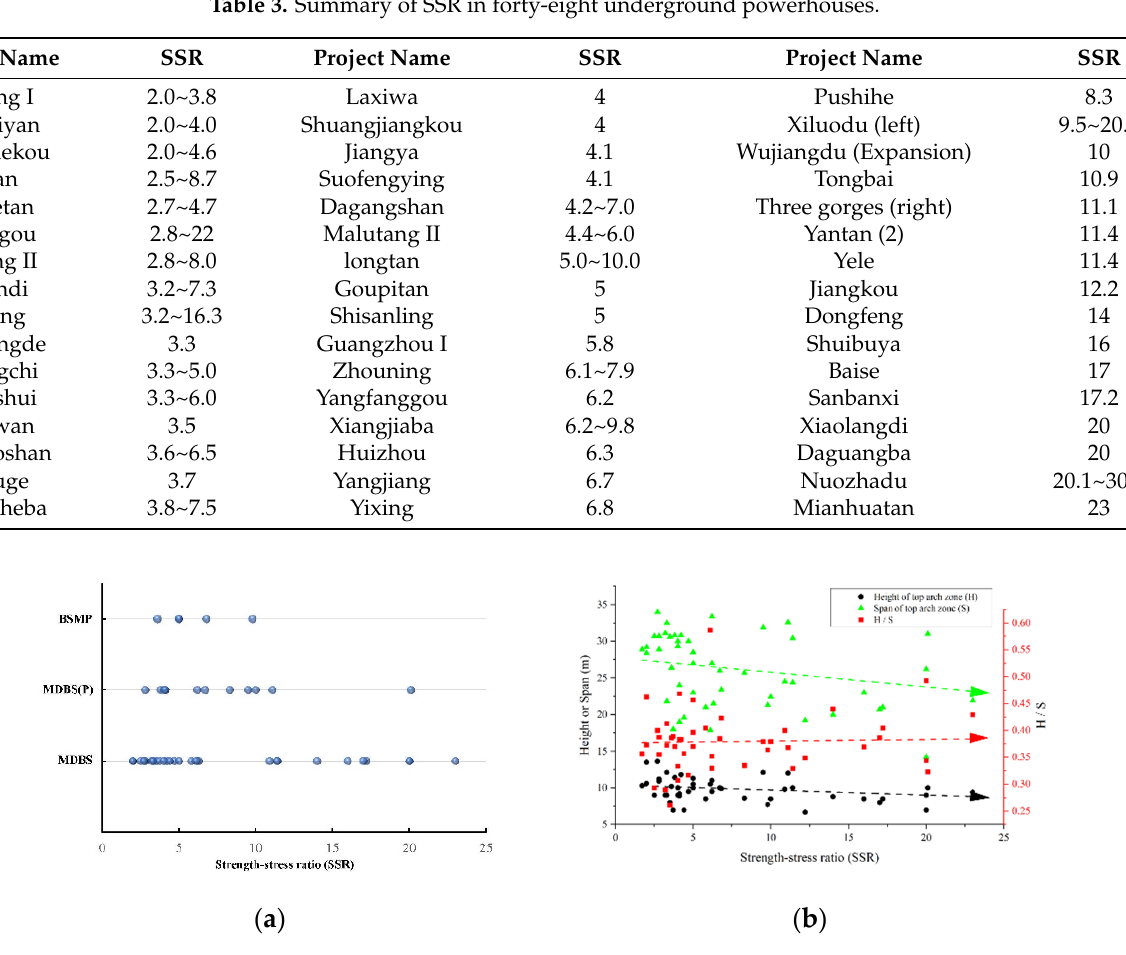
Figure 20. Statistics of excavation procedures at the top arch zone. ( a ) The distribution of excavation procedures based on SSR. ( b ) The relationship between H, S, H/S and SSR.